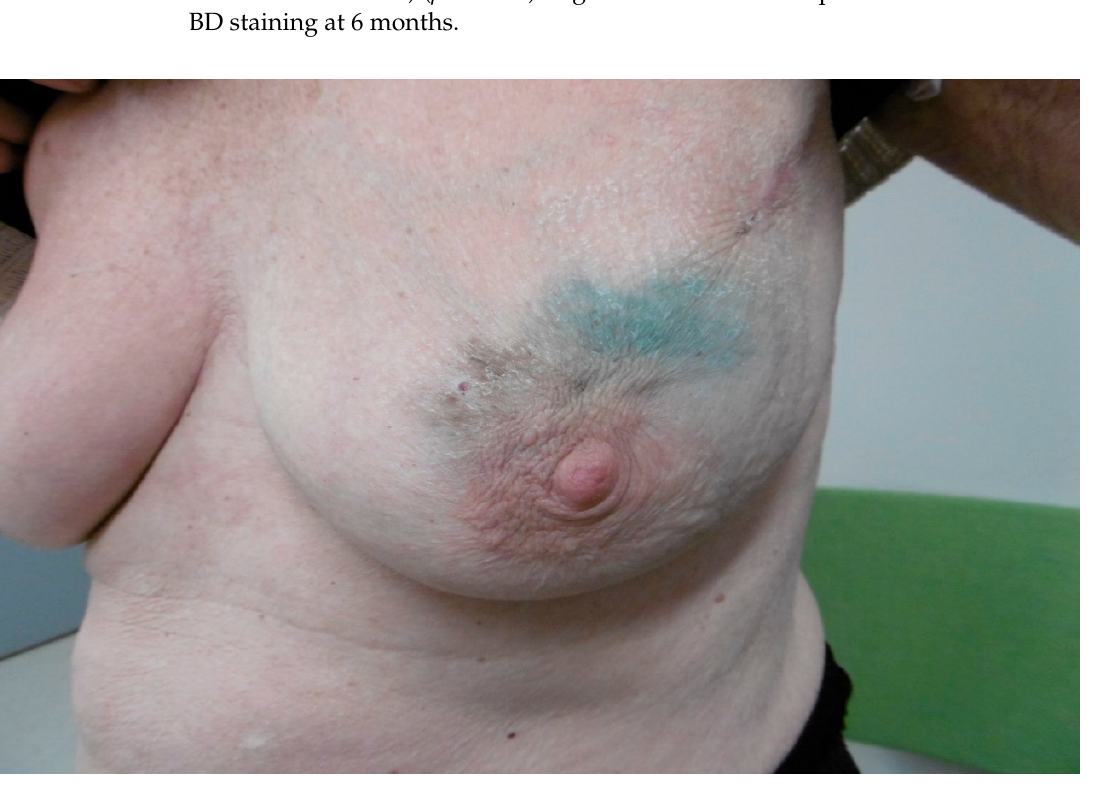
Table 3. Incidence and median size of SPIO staining postoperatively by injection site and volume.